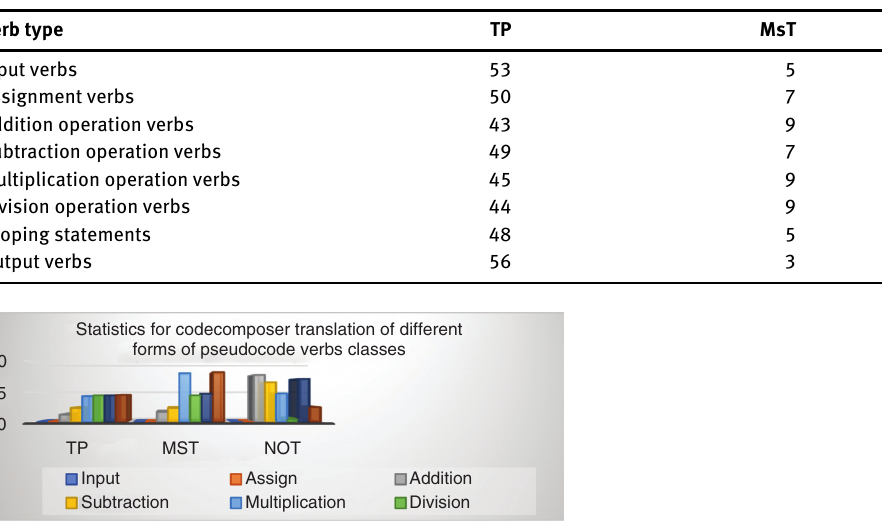
Table 6: CodeComposer Translation of Different Forms of Pseudocode Verb Classes.